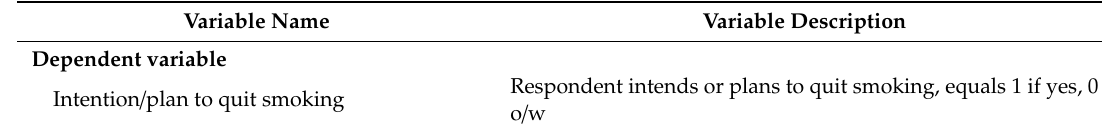
Table 1. Definition of variables used in the